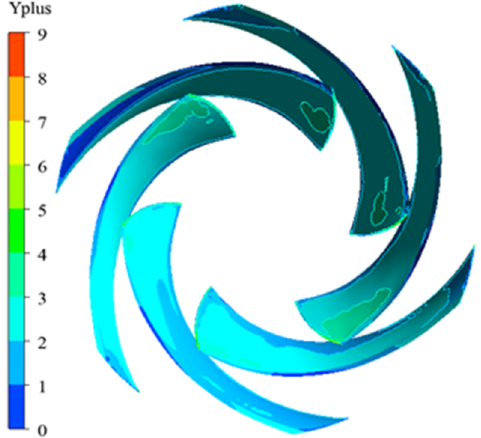
Figure 6. View of Y plus of blade.